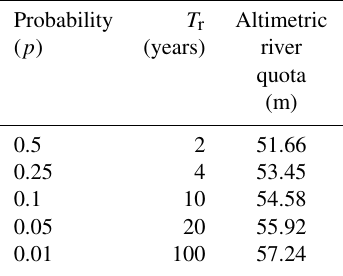
Table 3. Probability of the fluviometric level being matched or ex- ceeded. T r : flood return period.